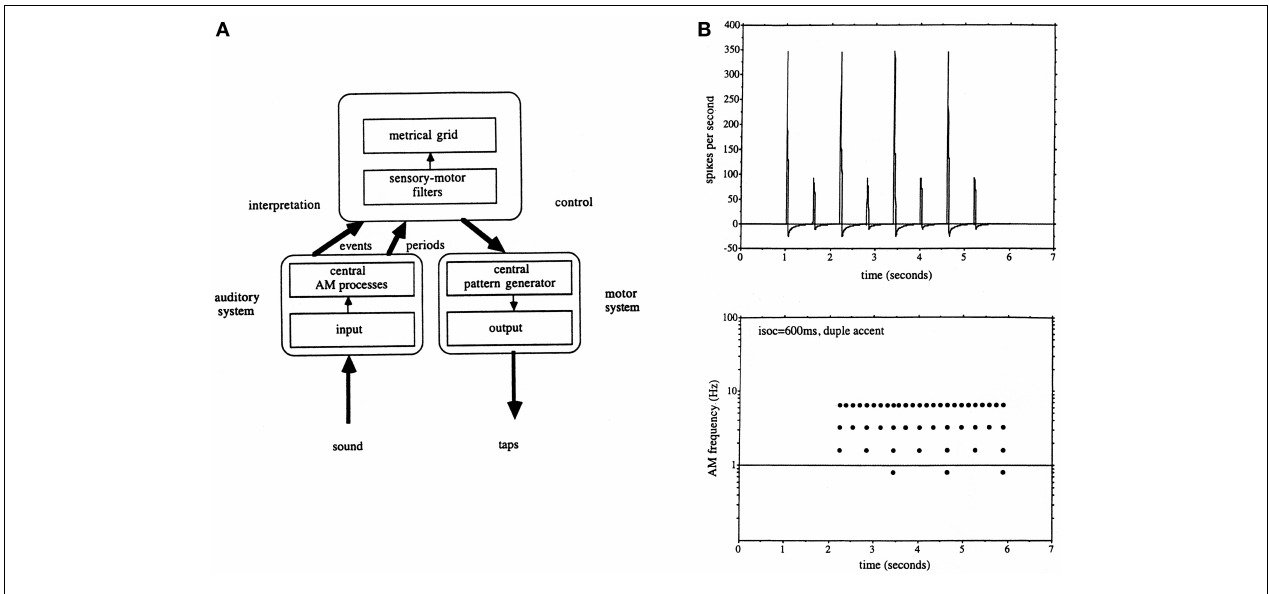
FIGURE 3 | (A) A reproduction of Figure 12 from Todd and Brown (1996) illustrating the auditory-motor hypothesis as it was envisaged at this time. The auditory system computed both low-pass and band-pass representations of a rhythmic sequence. This then allowed a central